Question: Draft a figure caption describing what is shown.
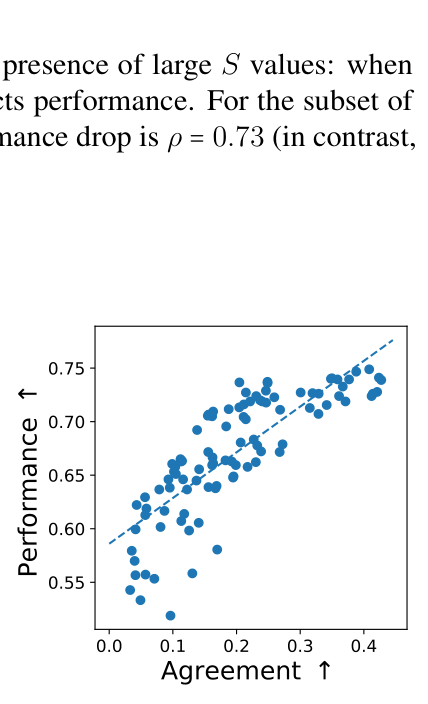
Answer: 5: PID agreement α(f,D) between datasets and models strongly correlate with model accuracy (ρ = 0.81).